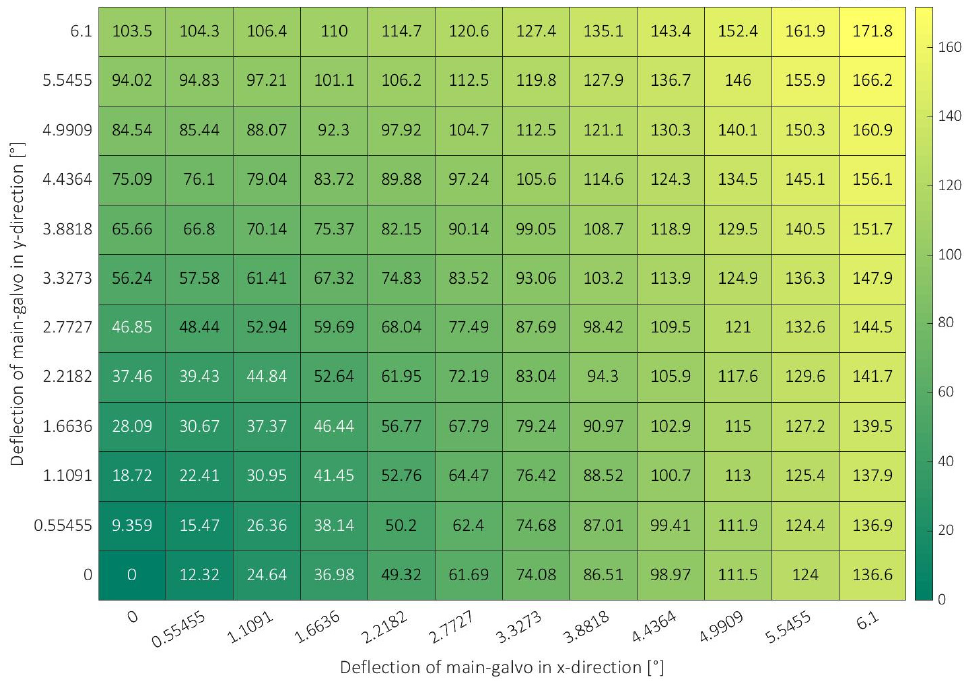
Figure 6. Lateral offset between the process spot and the not corrected measuring spot in dependency of the deflection of the two main-galvanometers.